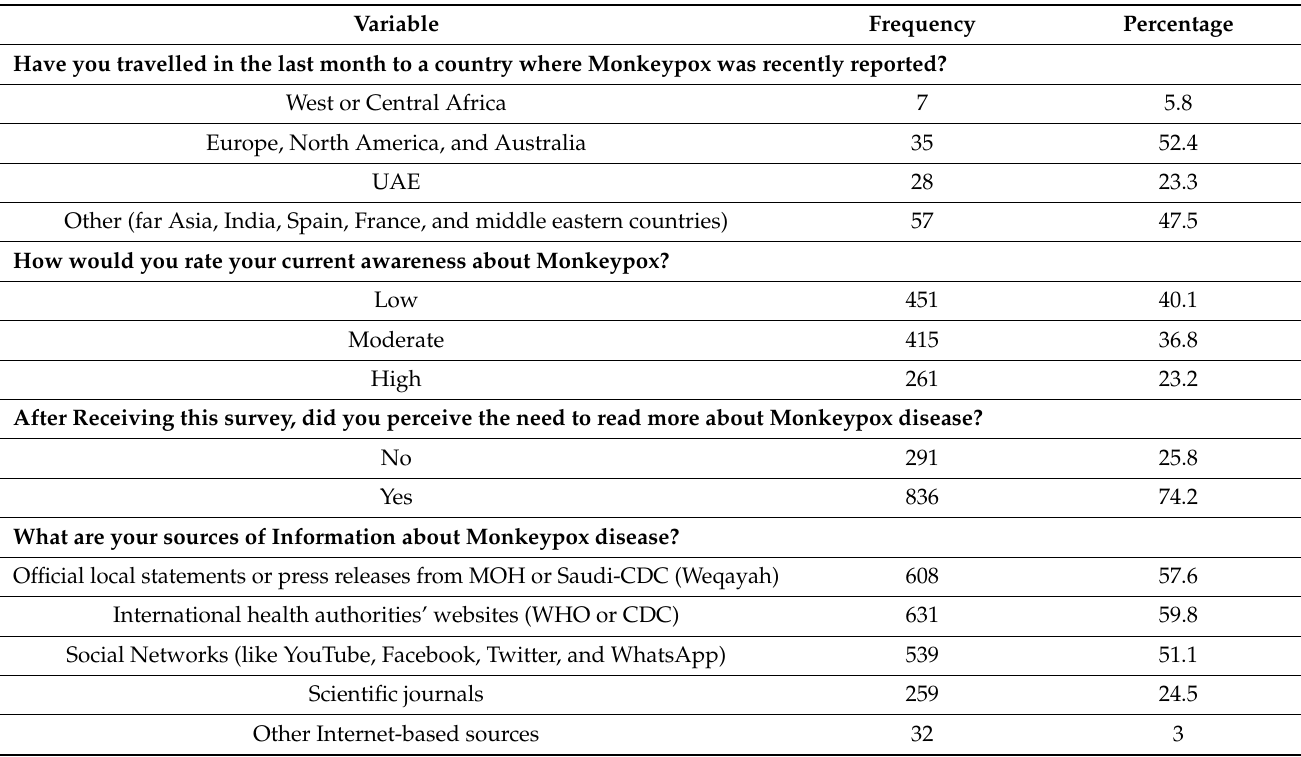
Table 2. HCWs’ awareness and sources of information about Monkeypox